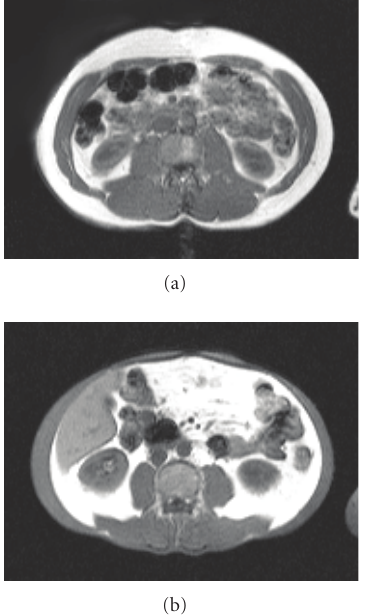
Figure 1: Abdominal magnetic resonance image (MRI) of a HAART-treated patient with normal fat distribution (a) and a patient with severe HAART-associated lipodystrophy with complete loss of subcutaneous fat and accumulation of intra-abdominal fat (b). Fat is shown white in these MRI